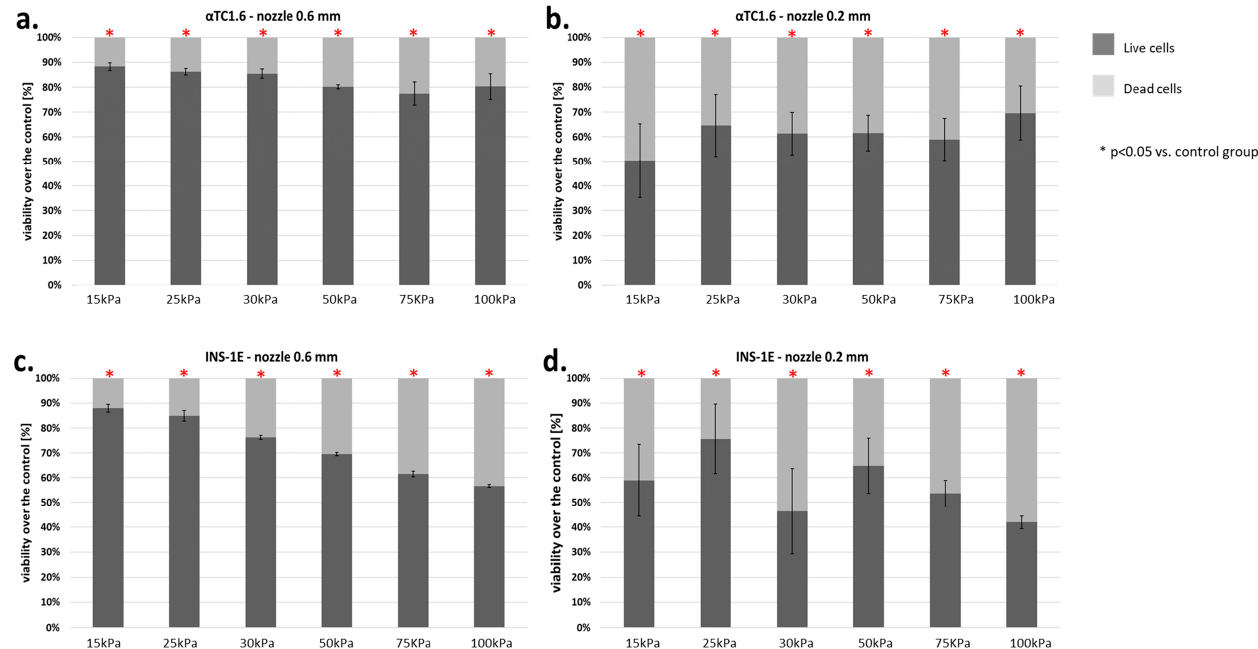
Figure 10. ( a – d ) Viability of pancreatic islet cells ( α -cells ( α TC1.6) and β -cells (INS-1E)) subjected to the bioprinting process with different pressures and nozzles with an internal diameter of 0.6 (Figure 6a,c) and 0.2 mm (Figure 6b,d). As a carrier material, 3% ( w/v ) alginate was used, and the vitality of the islets was assessed based on FDA/PI staining and determined in accordance with Equation (7). Our control consisted of cells right after the trypsinization process. The p -value for each pressure was calculated in comparison to the control group. In α -cells, p -value was determined using Fisher’s method and statistical significance ( p < 0.05) was observed in each pressure for both nozzles. In the case of 0.6 mm diameter nozzles, comparison of the viabilities of control and pressures 15, 25, and 30 kPa showed a loss in cell viability not exceeding 13%. Thus, those pressures can be considered suitable for the bioprinting process. In β -cells, p -value was determined using Fisher’s method, and statistical significance ( p < 0.05) was observed in each pressure of both nozzles. In the case of 0.6 mm diameter nozzles, comparison of the viabilities of control and pressures 15, 25, and 30 kPa showed a loss in cell viability not exceeding 18%. Thus, those pressures can be considered suitable for the bioprinting process. n =